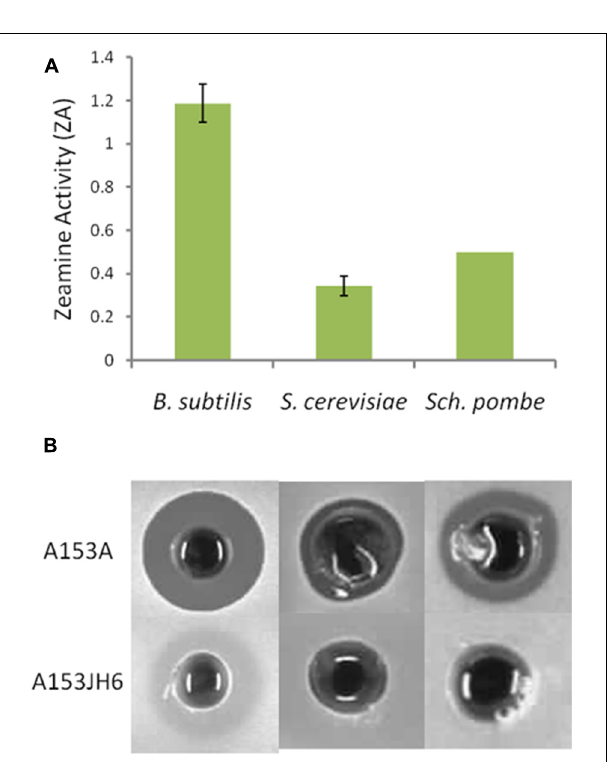
FIGURE 8 | Zeamine is toxic to the ascomycete yeasts Saccharomyces cerevisiae and Schizosaccharomyces pombe . (A) Bioactivity of cell-free supernatants of A153A show bioactivity against Bacillus subtilis and the ascomycete yeasts S. cerevisiae and S. pombe . A153 strains were grown in OMM at 25 ◦ C for 48 h and the bioactivities were quantified from bioassay plates incubated overnight at 30 ◦ C. Data shown are average values ± SD from at least three experiments. (B) Supernatants from stationary phase cultures of A153JH6 grown under the same conditions produce no antibiotic halos on bioassay plates, confirming that the halos are produced by zeamine.